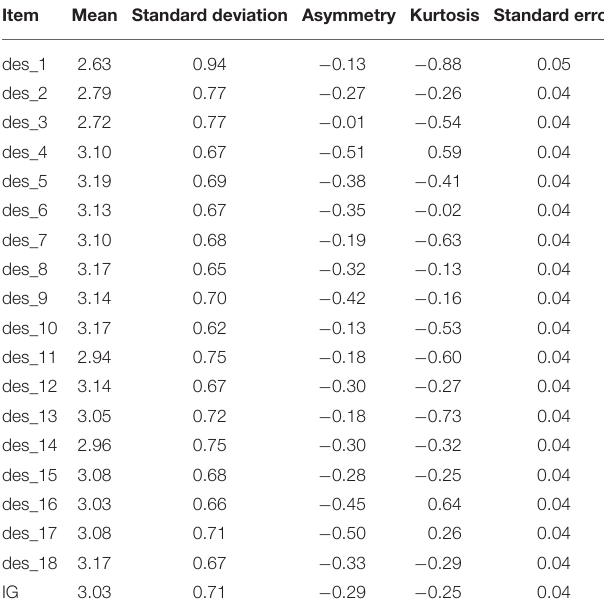
TABLE 3 | Descriptive statistics for each item and